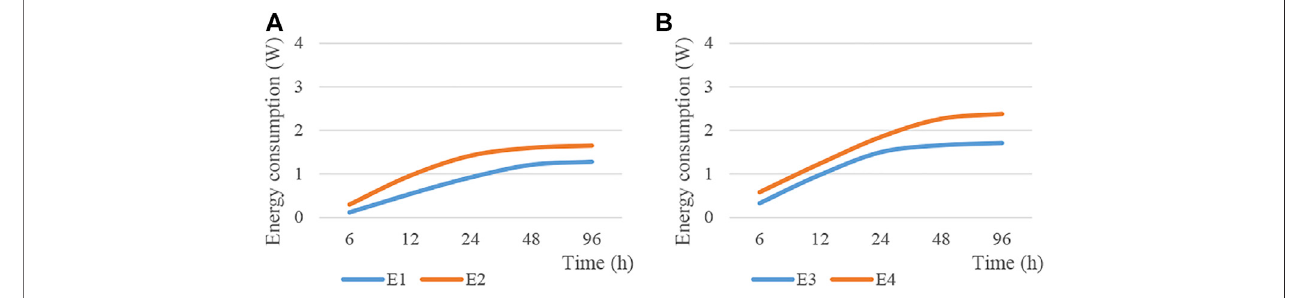
FIGURE 11 | Comparison of energy consumption under different experimental conditions. (A) shows the effect of electrolyte type on energy consumption (B) shows the effect of voltage on energy